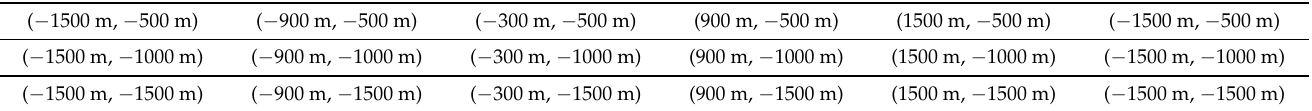
Table 2. Positions of all targets in XY-plane.